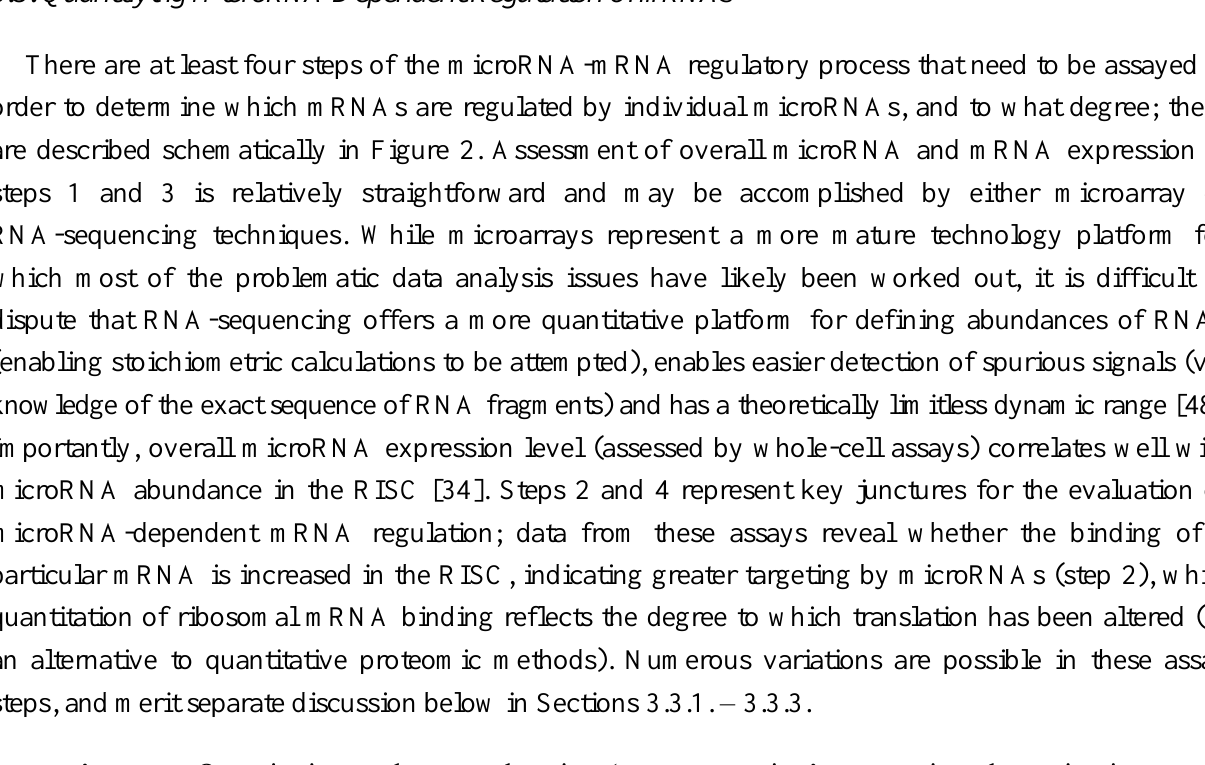
Figure 2. Quantitative and comprehensive ‘next-generation’ sequencing determinations used to measure mature microRNAs (step 1), to measure RISC-bound mRNA at step 2, to measure global RNA at step 3 and to measure ribosome-translated mRNA at step